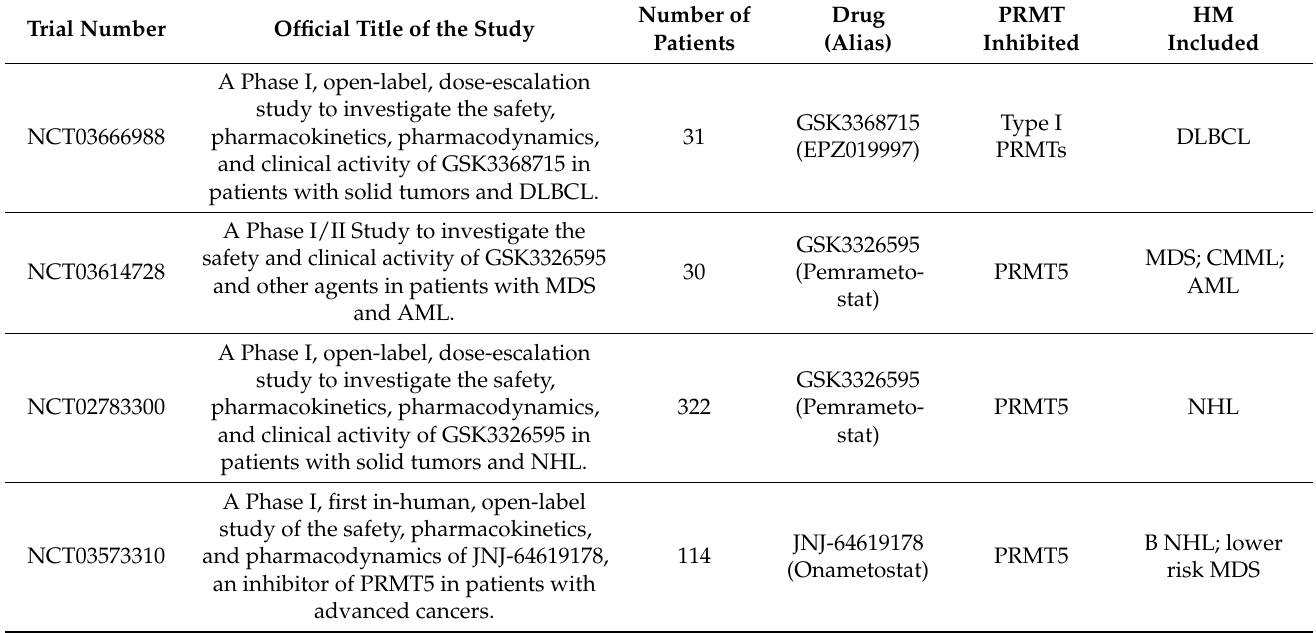
Table 2. Clinical trials involving PRMT inhibitors in hematological